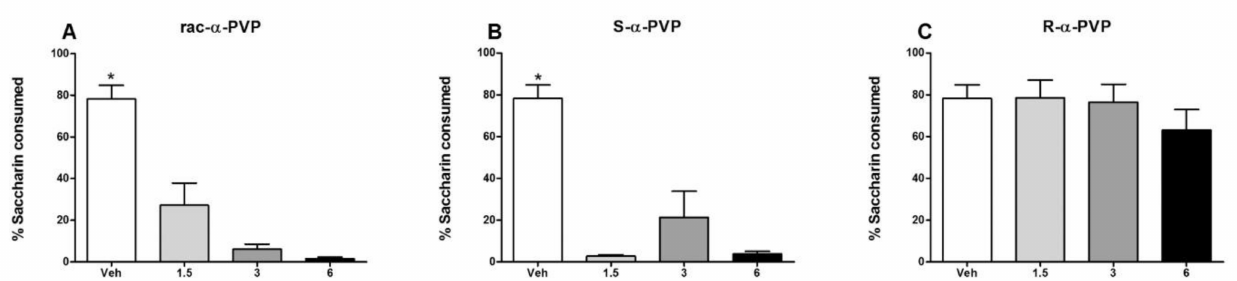
Figure 14. Avoidance tests with racemic α -PVP ( A ), S- α -PVP ( B ) and R- α -PVP ( C ). * Significantly different from 1.5, 3, and 5